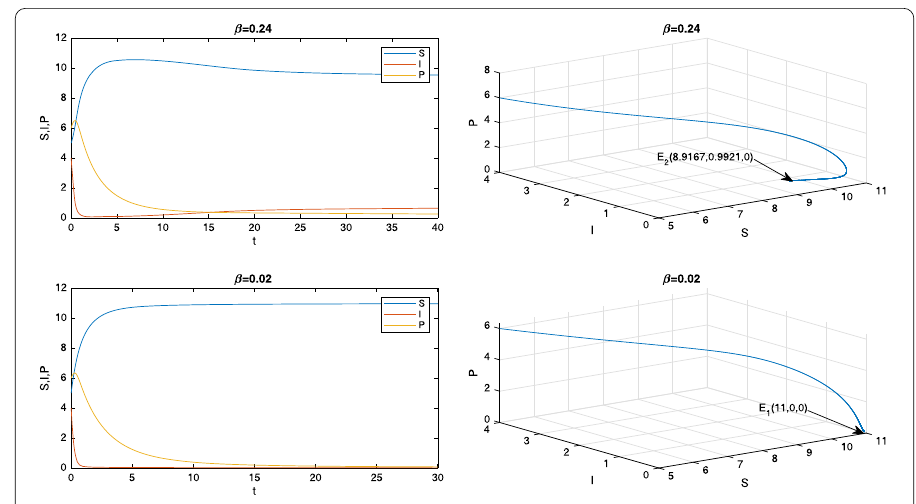
Figure 1 Time series and phase diagram of the predator-extinction equilibrium point E 2 (8.9167,0.9921,0) and axial equilibrium point E 1 (11,0,0) with different values of β and q =